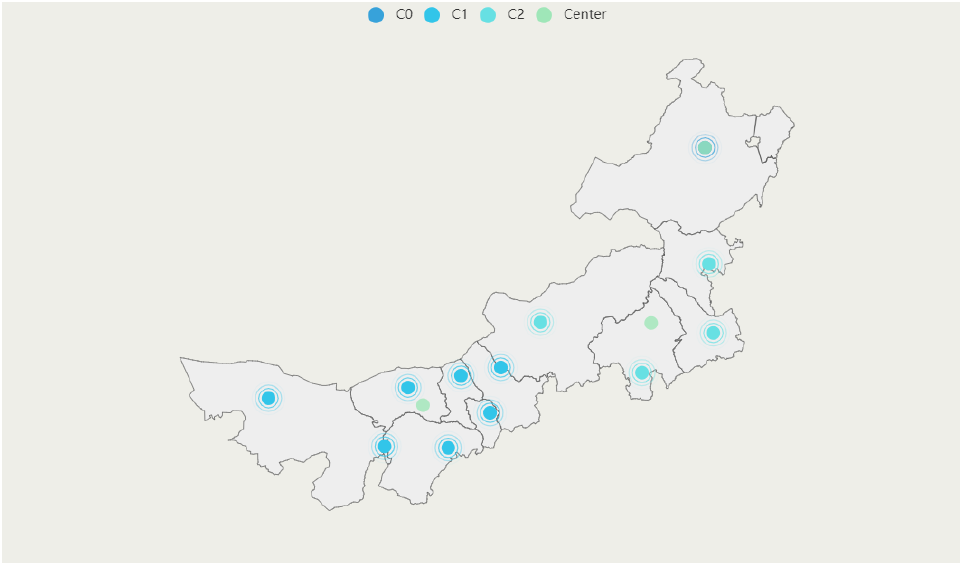
Figure 5. The location results for the GCM. Model 2: Five-indicator clustering model (5ICM). This model contains five normalized indicators used in this paper: the longitude, the latitude, the per capita disposable income of urban residents, the permanent urban population and the population density. Euclidean distance is used to compute the distance between cities, the results are obtained by K -means clustering as shown in Table 8 and Figure 6. C0, C1, C2 and Center are in different colors in Figure 6. Table 8. The location results for the 5ICM. Clustering